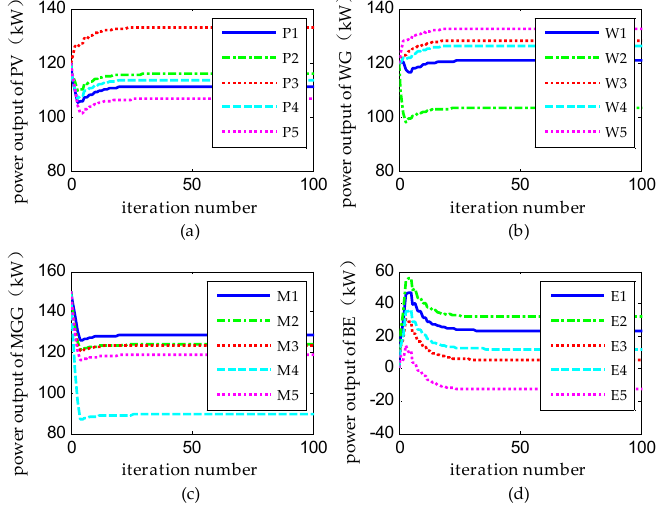
Figure 3. Dispatch results in Scenario A . ( a ) Power output of PV; ( b ) Power output of WG; ( c ) Power output of MGG; and ( d ) Power output of BE.